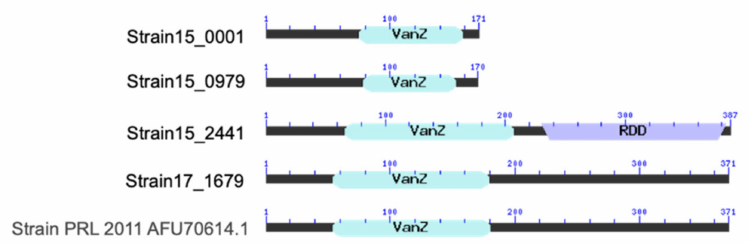
Figure 3. Domain of the putative protein encoded by the vanZ gene in the BA15 and BA17 genome, obtained by CDART (domain architectures) from the NCBI